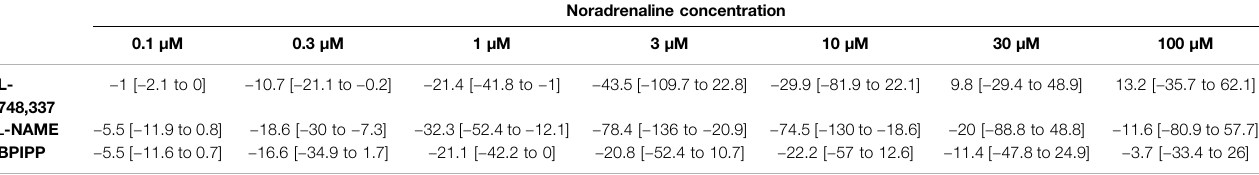
TABLE 5| Meandifferences (MD) fornoradrenaline-inducedcontractions ofhuman prostate tissues after application ofeither L-748,337, L -NAME, or BPIPP both tocontrol and mirabegron groups, followed by application of mirabegron (10 µM) or DMSO for controls, shown for each applied agonist concentration and with 95% con fi dence intervals (CI) (in square brackets, low to high) (% of KCl-induced contractions). Differences in contraction at given agonist concentrations were calculated for each single experiment (i. e., between mirabegron and control group, for corresponding, paired samples from the same prostate in each single experiment), and are expressed as MD with95%CI.Dataarebasedonexperimentsonserieswith n (cid:1) 5prostatesforeach mirabegronconcentrationand corresponding controlswithL-748,337and L -NAME and n (cid:1) 9 prostates with BPIPP, i. e. 19 prostates in